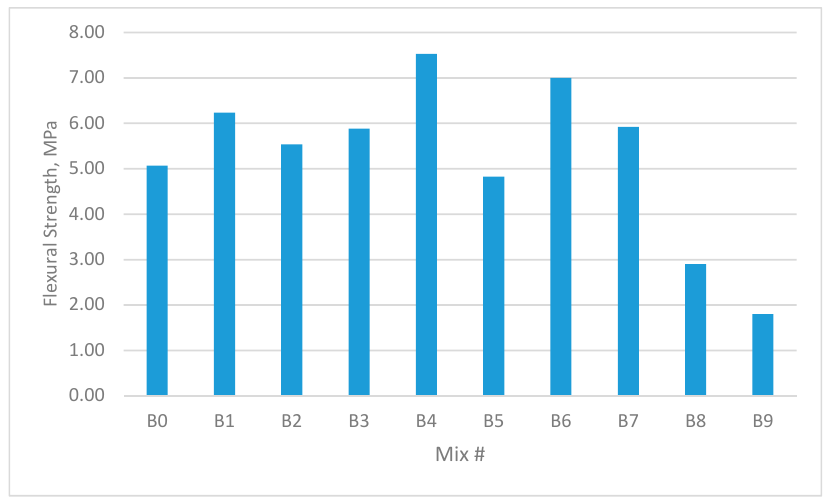
Figure 11. Flexural strength of concrete beams with W/B ratio 0.35.